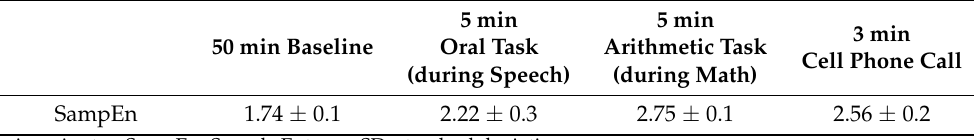
Figure 1. Study design (repeated measures of salivary cortisol and heart rate variability. Table 2. Mean Sample Entropy during baseline and consecutive exposures ± SD (n =